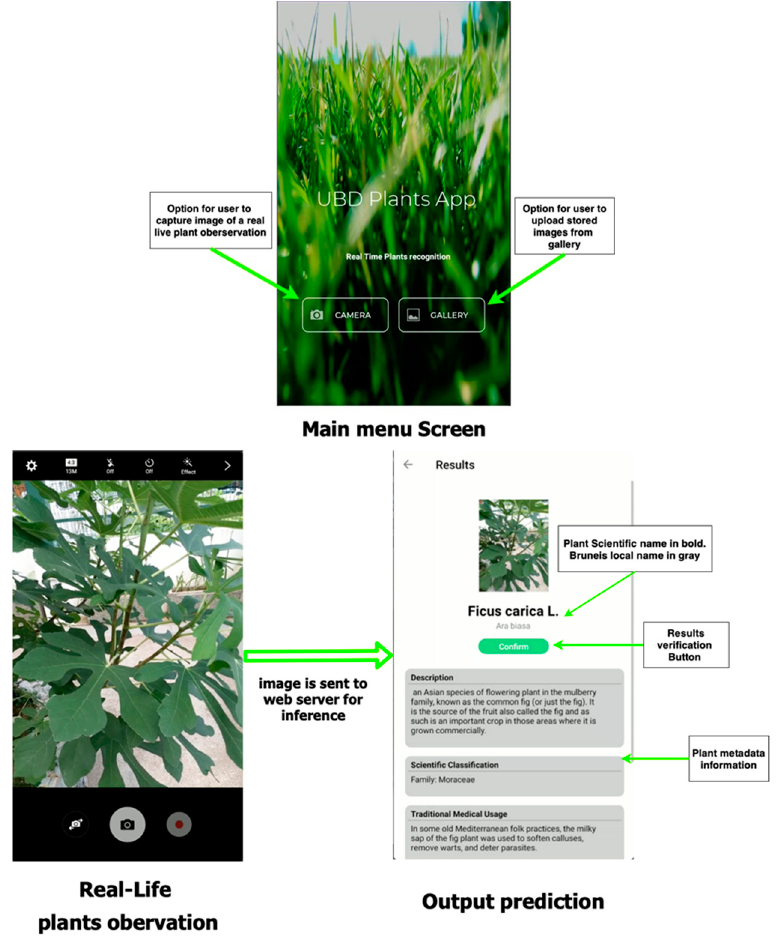
Figure 5. Screenshot of GUI mobile application.